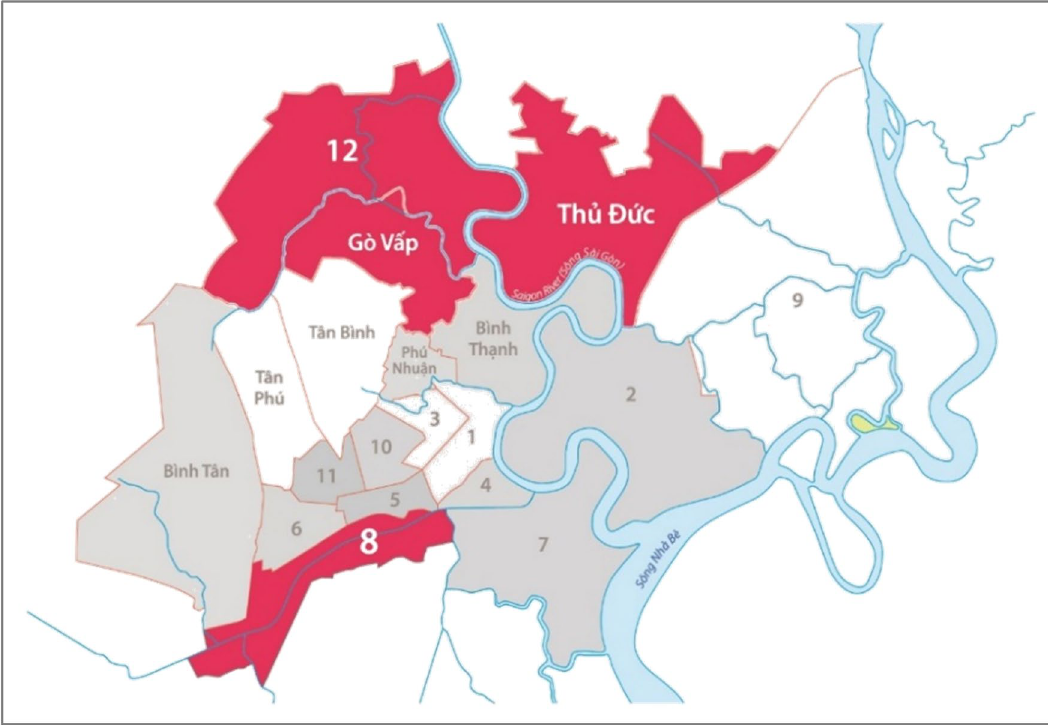
Figure 1. Ho Chi Minh City map with Communities for Healthy Hearts programme areas highlighted. Source : Adapted from Google images by Jayden Nguyen using Adobe Illustrator Version CC 2017.1 (21.1.0) to highlight the intervention districts. This image was adapted according to Google’s fair use